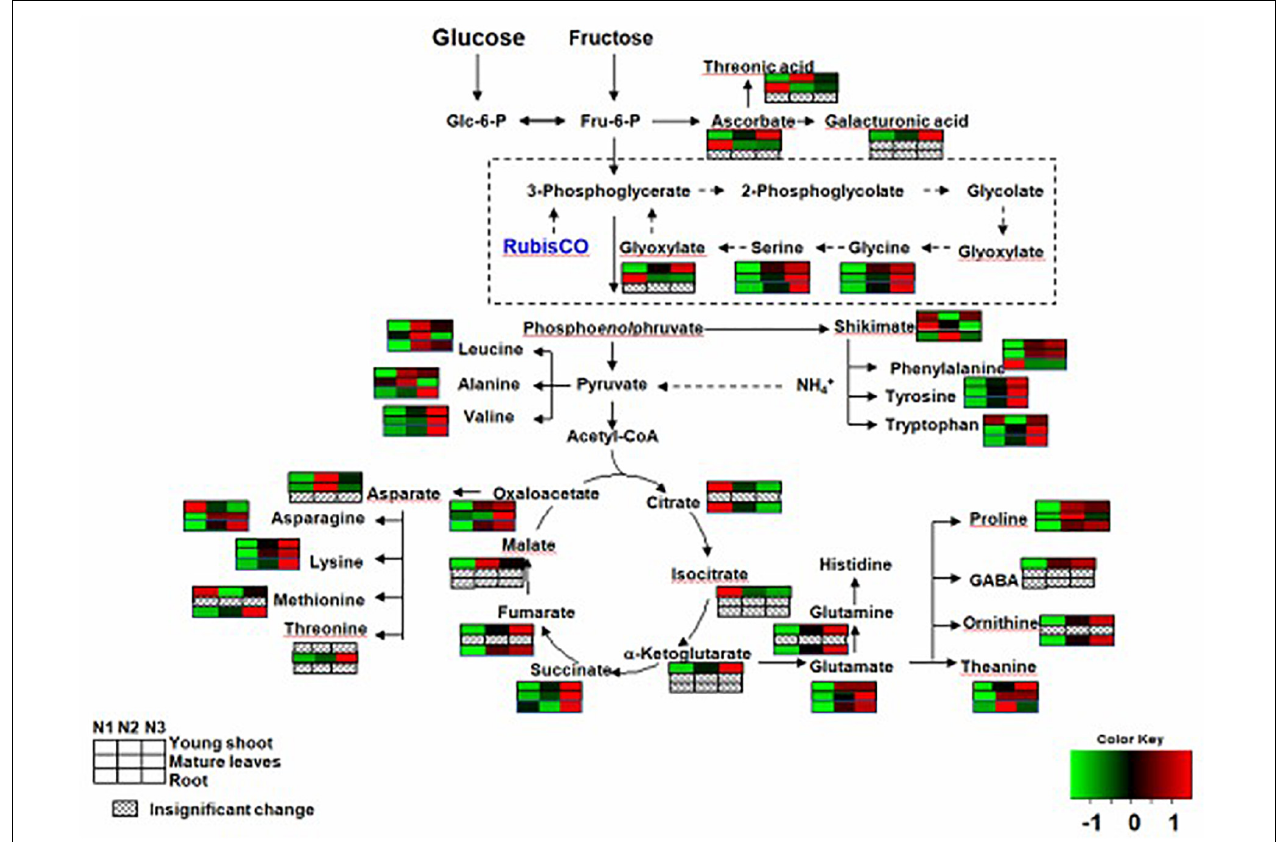
FIGURE 3 | Changes in free amino acids and organic acids of young shoots, mature leaves, and roots under low (0.3 mmol/L, N1), intermediate (1.5 mmol/L, N2), and high levels of nitrogen (4.5 mmol/L, N3). The relative abundance of metabolites is illustrated on a red (high) to green (low) scale. The differences were considered to be significant when p <